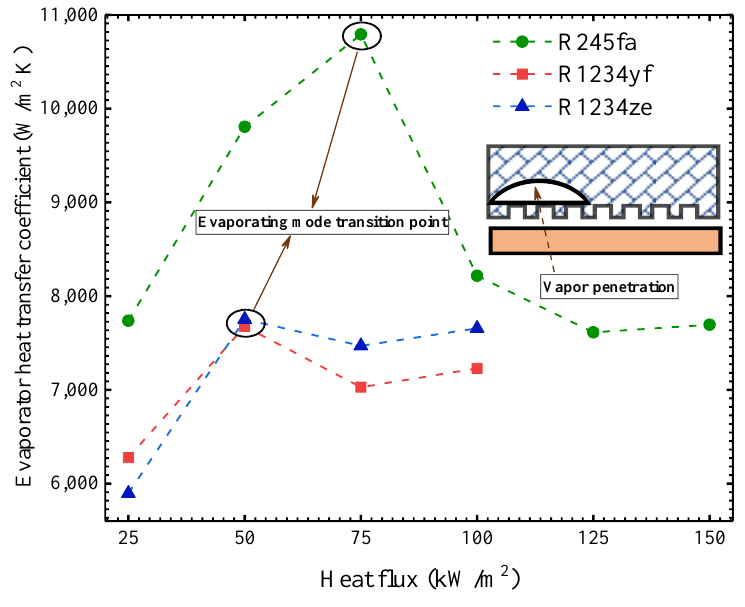
Figure 3. Variation of the evaporator heat transfer coefficient versus the applied heat